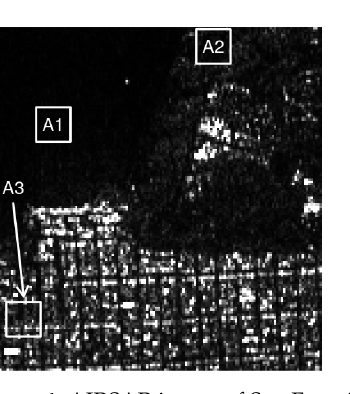
Figure 4. AIRSAR image of San Francisco (channel HH) with selected